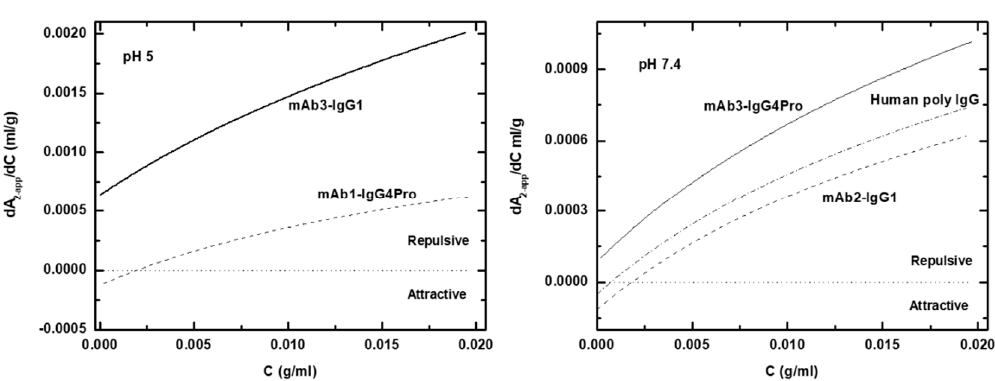
Figure 10. Protein–protein-interaction parameter d A 2 -app /dC for pH 5 and pH 7.4 data. Note the concentrations are present in g/mL (cgs units) in order to be consistent with the derivation of the equations [12], and correspond to a concentration range of 0–20 mg/mL. The parameters used to generate these curves are: M 1 = 150,000 g/mole, hydrated radius 4.39 nm, hydration 0.3 g-H 2 O/g-protein, axial ratio 5, monomer–dimer K d 1 × 10 − 3 M, protein partial specific volume = 0.73 mL/g, solvent partial specific volume 0.993 mL/g, temperature 20 ◦ C, and solvent density 1.0 g/mL. The salt concentration for pH 5 was set to 60 mMolal, and for pH 7.4 to 150 mMolal. For either condition, curves for the mAbs having the lowest Z DHH (dashed lines) and highest Z DHH (solid lines) are shown. For pH 7.4, a curve for human poly IgG (dash-dot) is shown. The horizontal dotted line at 0 corresponds to ideal conditions, with values less than zero corresponding to net attraction and greater than 0 to net